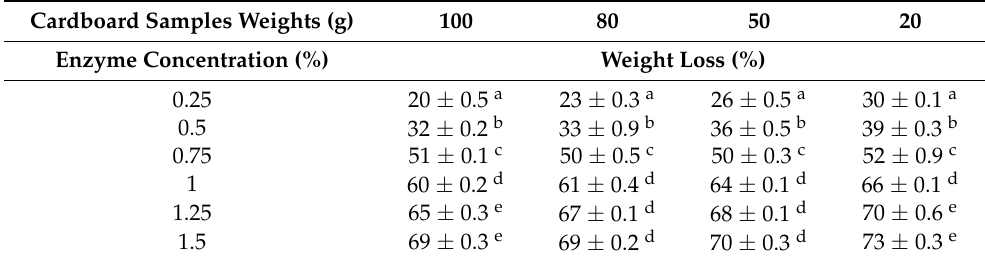
Table 1. Weight loss (%) of different cardboard samples after enzymatic hydrolysis. Mean and standard deviations were used to show the values. The presence of different superscript letters within the same column indicates significance ( p <